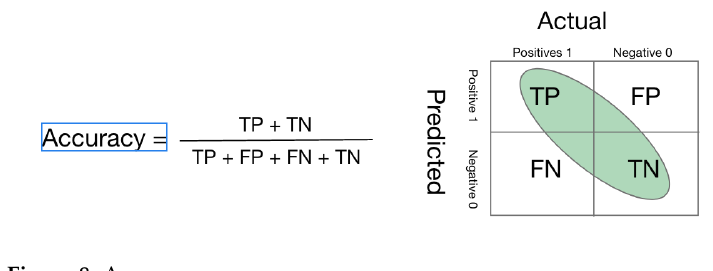
Figure 8. Accuracy.